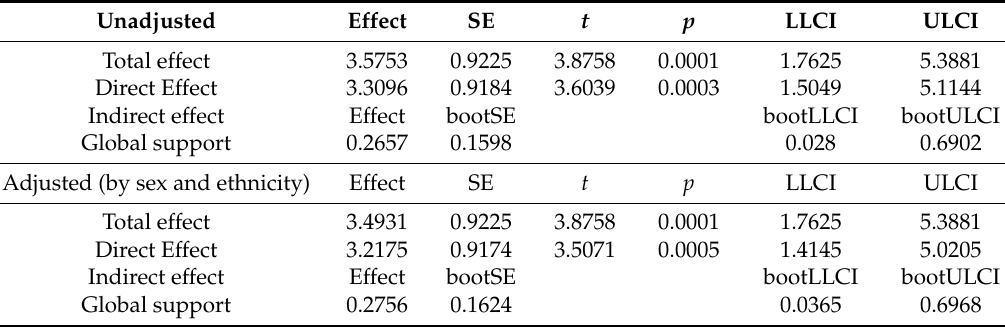
Table 4. Mediation effect of social support in this